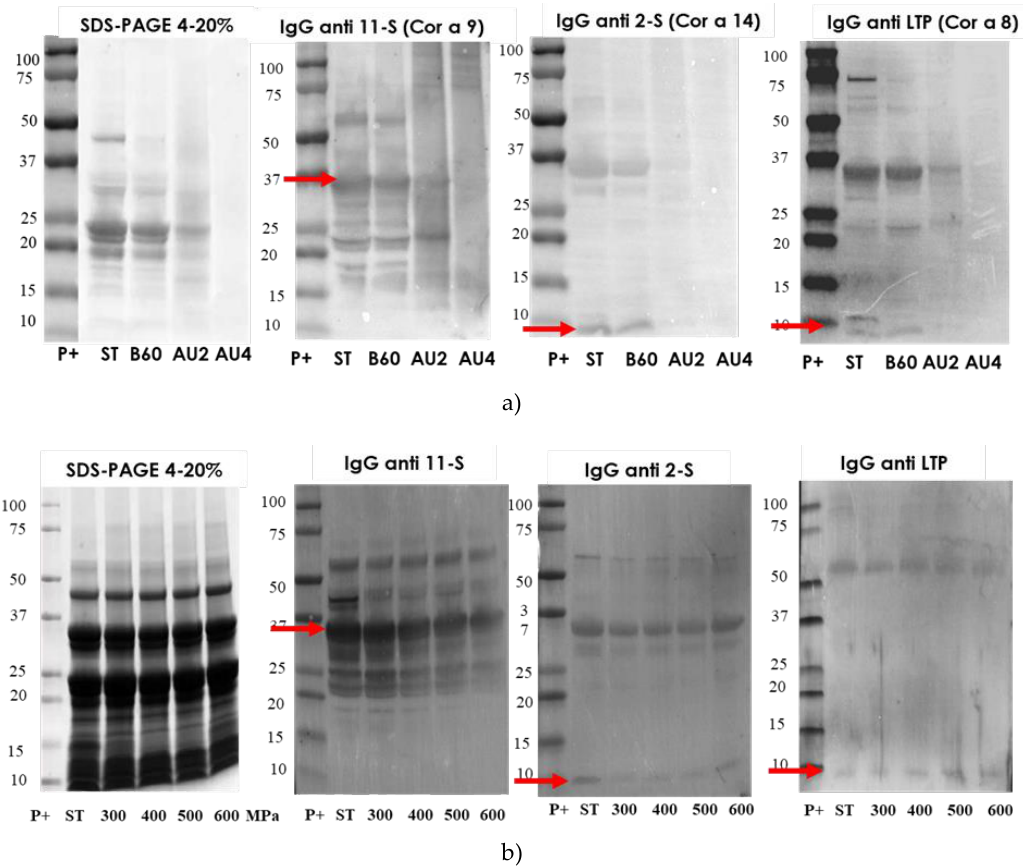
Figure 4. ( a ) SDS-PAGE and IgG anti-11S, anti-2S, and anti-LTP immunoblots analysis of control (ST), boiled 60 min (B60) and autoclaved at 121 ◦ C at 30 min (AU2) and 138 ◦ C 30 min (AU4) hazelnut samples. ( b ) SDS-PAGE and IgG immunoblot analysis of control and high-hydrostatic pressure (HHP) 300 to 600 MPa (300, 400, 500, 600) processed hazelnut samples Molecular weight marker was Precision Plus (P +